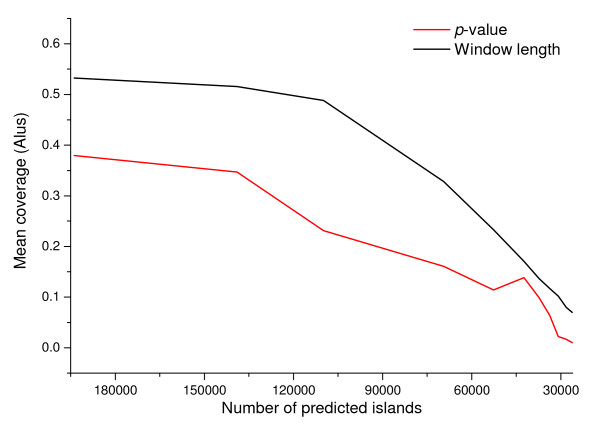
Variation of the mean coverage by Alus in different predicted island-sets obtained by varying the CpGcluster p-value and the SWA window length.